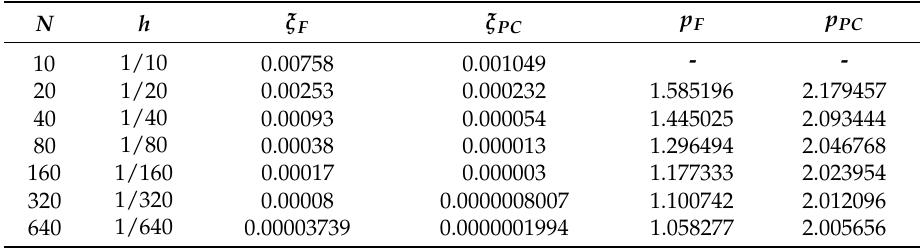
Table 3. Error analysis of numerical methods ENFDS and ABM for β = 2, γ = 1 according to Runge’s rule (26).